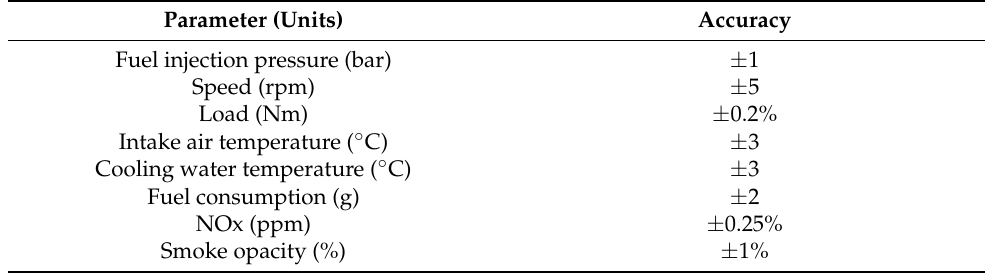
Table 4. Measurement accuracy of the main